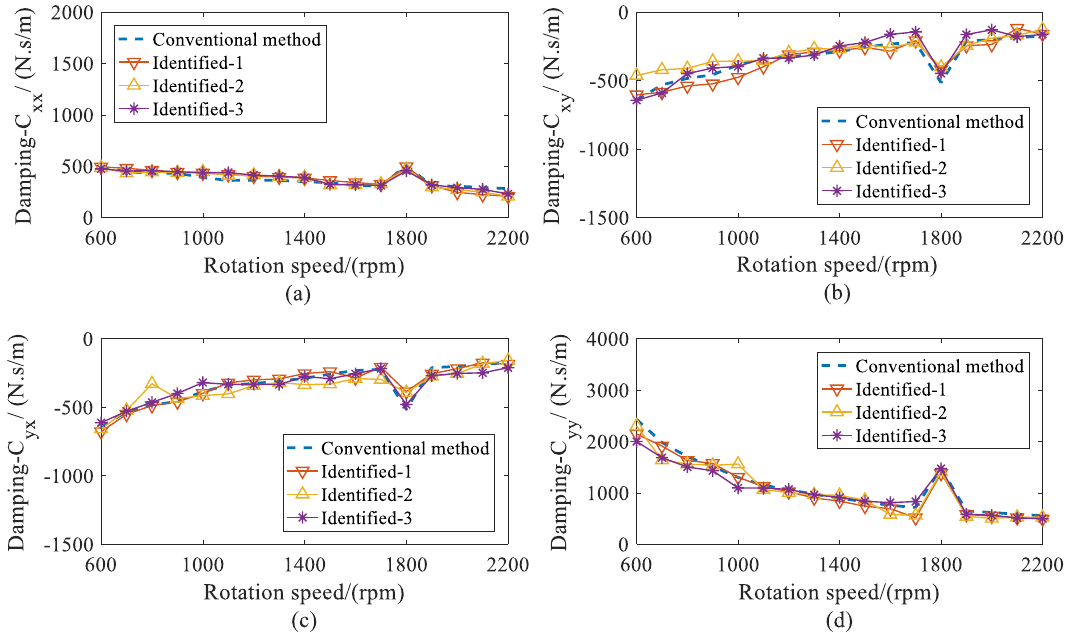
Figure 13. Comparison for damping coefficients of bearing 1 versus rotor speed. ( a ) direct damping coefficients C xx ; ( b ) cross-coupled damping coefficients C xy ; ( c ) cross-coupled damping coefficients C yx ; ( d ) direct damping coefficients C yy .